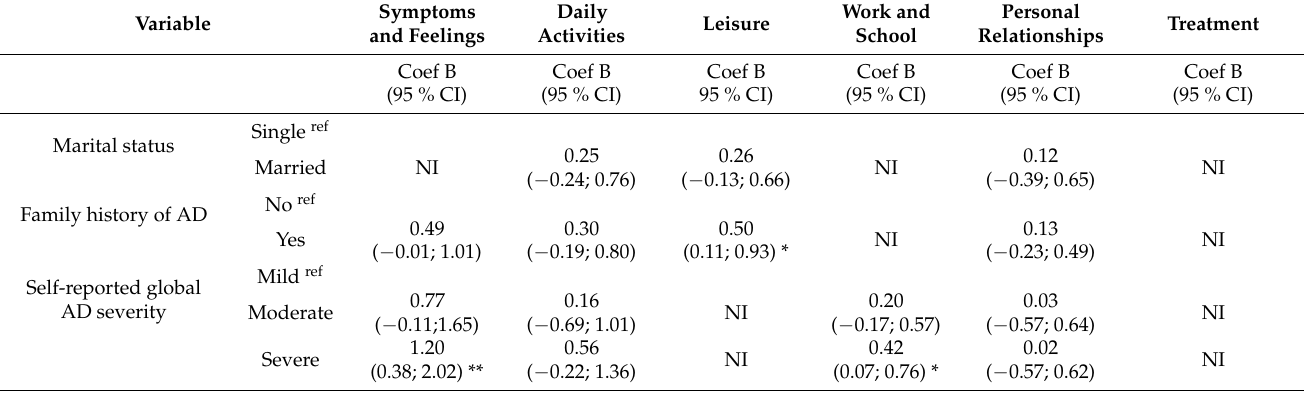
Table 6. Multiple linear regression models for estimating factors influencing domain-specific DLQI. Symptoms Daily Variable and Feelings Activities